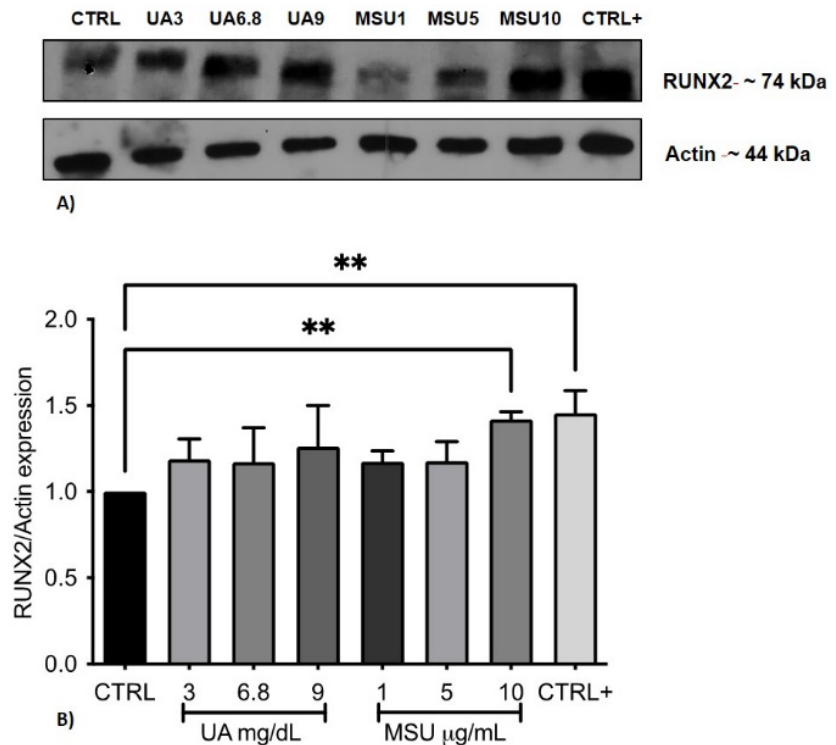
Figure 5. Effect of UA and MSU crystals on Runx2 expression. ( A ) Blot representative of the levels of Runx2 protein expression in relation to actin (internal control). ( B ) Graph of the densitometric analysis of Runx2 expression in the control group and treatment groups. The values in the columns are the average ± SD of at least 3 independent experiments; Dunnett’s test, ** p < 0.01 .